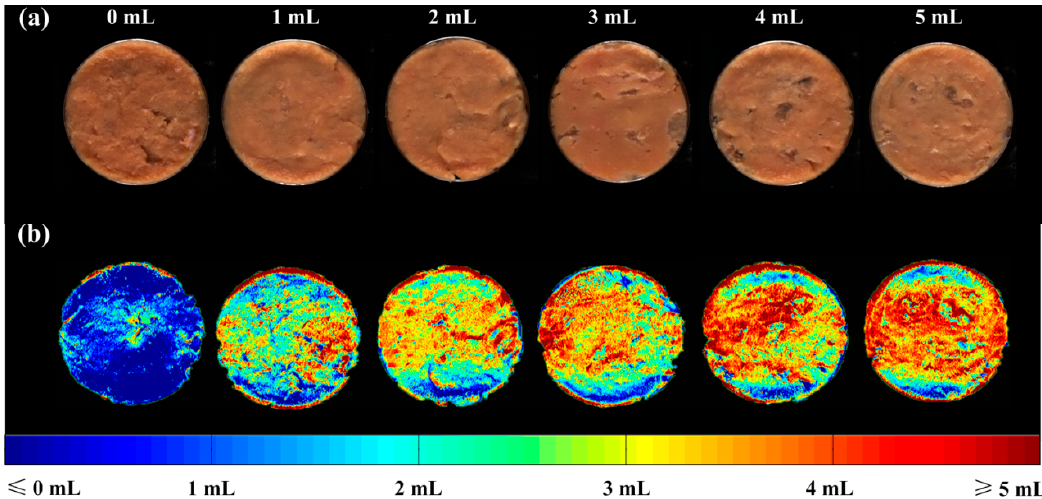
Figure 5. Visualization of samples adulterated with different adulteration levels of carrageenan. ( a ) pseudo-color images and ( b ) visual distribution maps.